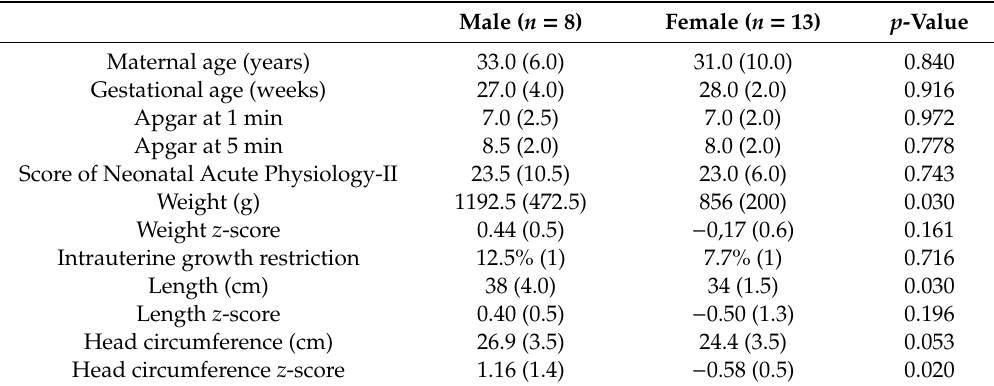
Table 5. Cohort baseline characteristics between infant